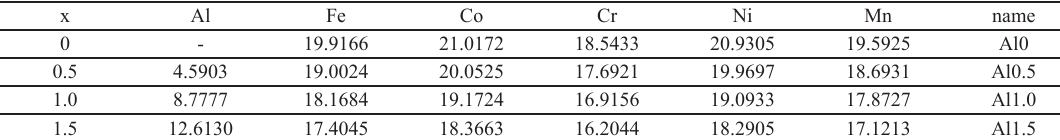
Figure 2. XRD patterns of AlxFeCoCrNiMn cladding Table 3. Chemical compositions of AlxFeCoCrNiMn high entropy alloy powder(mass fraction/%).